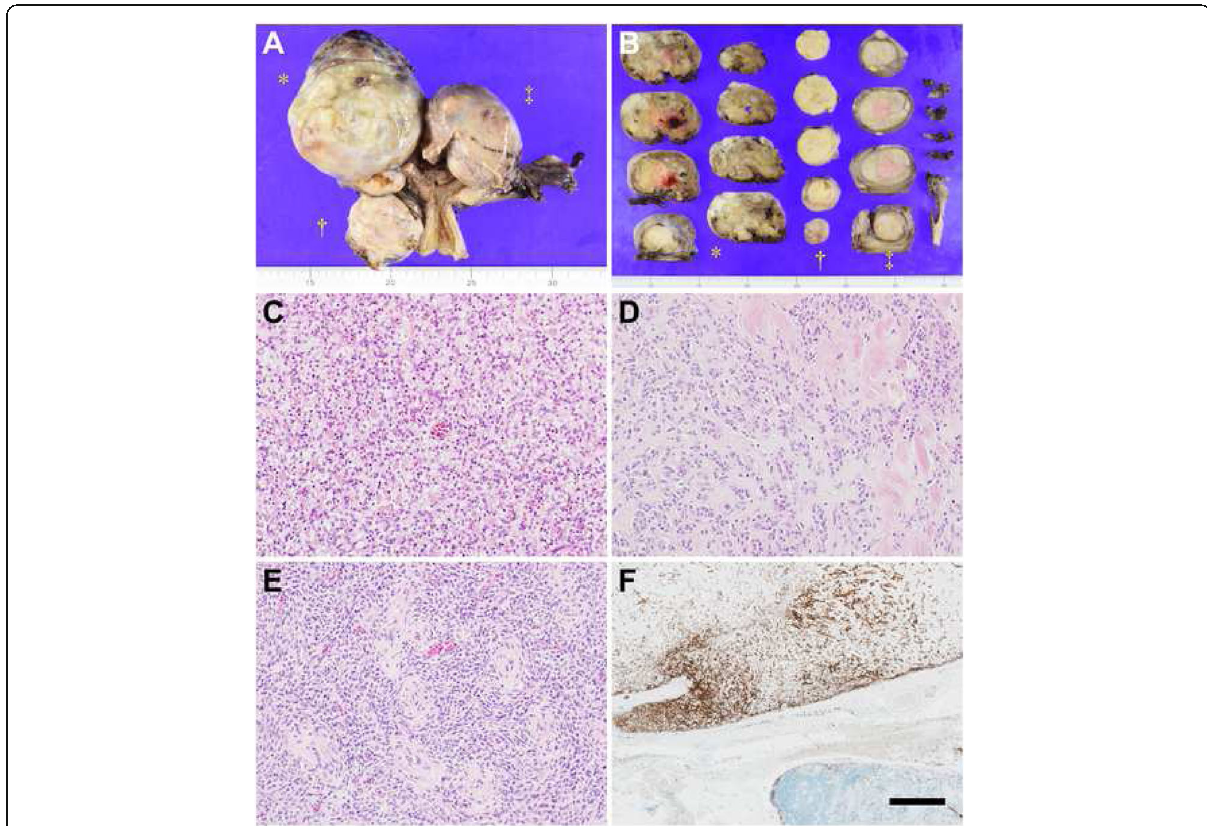
Fig. 2 Photographs of the surgically removed uterine tumor. a Three uterine masses separately located on the right-anterior (*) and right- posterior ( † ) serosa and within the fundal myometrium ( ‡ ) of 9.5 cm, 4.5 cm, and 6.5 cm in largest diameter, respectively. b Cut surfaces of the uterine tumor by lesion, which were heterogenously tan to yellow with focal hemorrhage (*), white with yellow plaques ( † ), and pale-gray with intratumoral mosaic demarcation ( ‡ ). c - e Cytohistologic variation by lesion. ( c ) Uniform cells having round to ovoid nuclei and scant cytoplasm proliferating with intercellular edema (hematoxylin and eosin [HE] stain, × 100). d Tumor cells arranged in trabecular cords admixed with abundant fibromyxoid matrix (HE, × 100). e Classic morphology of low-grade endometrial stromal tumor characterized by numerous whorls around small vessels (HE, × 100). f Tumor extension into the extrauterine vein positive for CD10 (the upper area), adjacent to nonmetastatic pelvic lymph nodes (immunohistochemical [IHC] stain; bar, 0.5